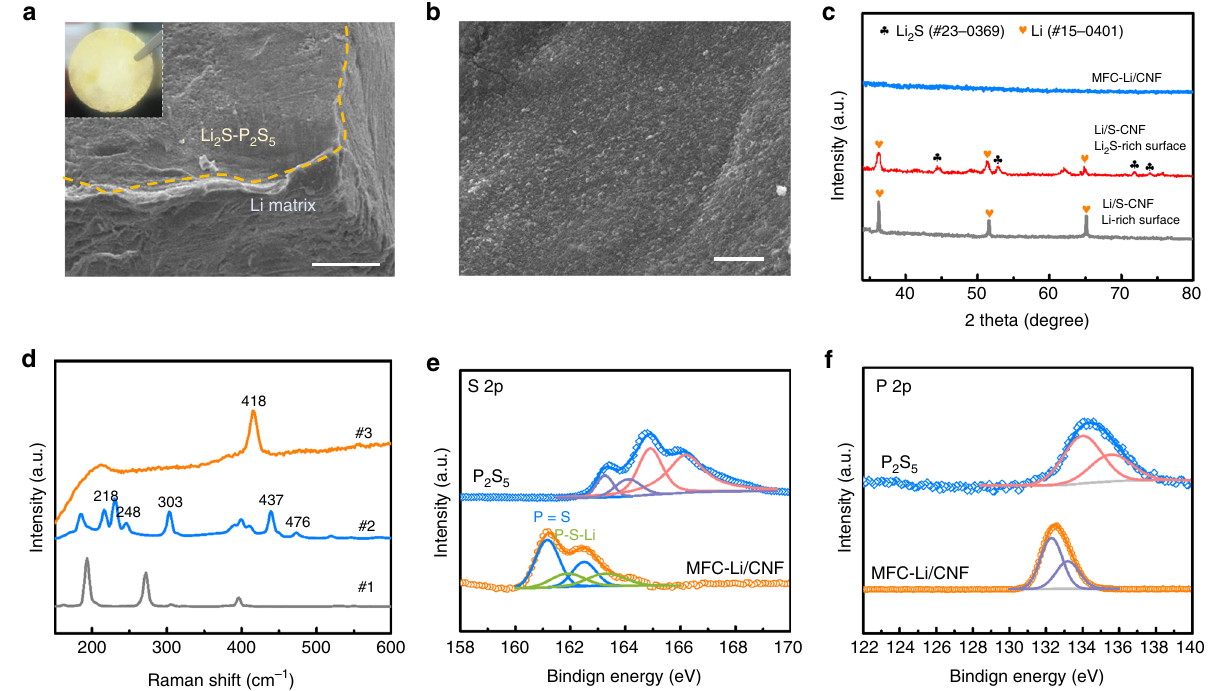
Fig. 4 Protective coating on the porous Li electrode. a SEM image of the edge of MFC-Li/CNF; b surface SEM image of MFC-Li/CNF; c XRD of the MFC-Li/ CNF surface (the same as b ); Li 2 S-rich and Li-rich surfaces of the Li/S – CNF. The Li 2 S-rich surface was formed from the gravitational setting of Li 2 S during the formation process of Li – S/CNF composite. And the solid electrolyte layer also evolved from the Li 2 S-rich surface. d Raman spectra for P 2 S 5 (#1) and the coated Li/S – CNF electrode after drying (50 °C, #2) and after heat treatment (160 °C, #3). e , f XPS spectra of S 2p ( e ) and P 2p ( f ) for P 2 S 5 and MFC-Li/ CNF. Scale bar for a is 100 µ m, for b is 50 µ